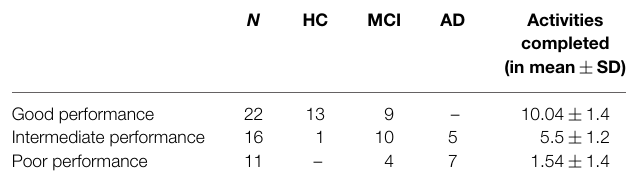
TABLE 5 | Ecological assessment results .